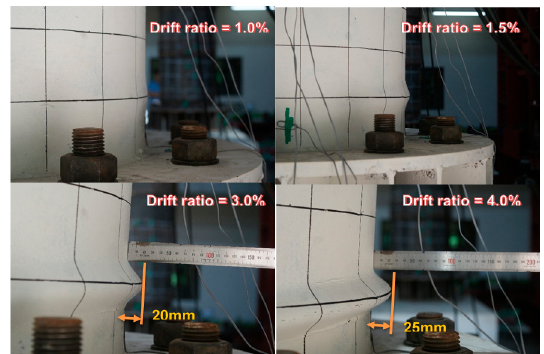
Figure 29. Buckling failure of outer tube of SP-W.